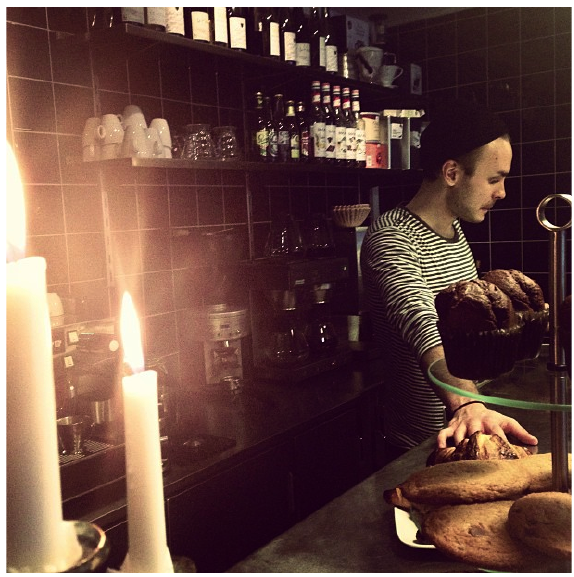
Figure 2. The photographer wants to emphasize positive everyday life in the